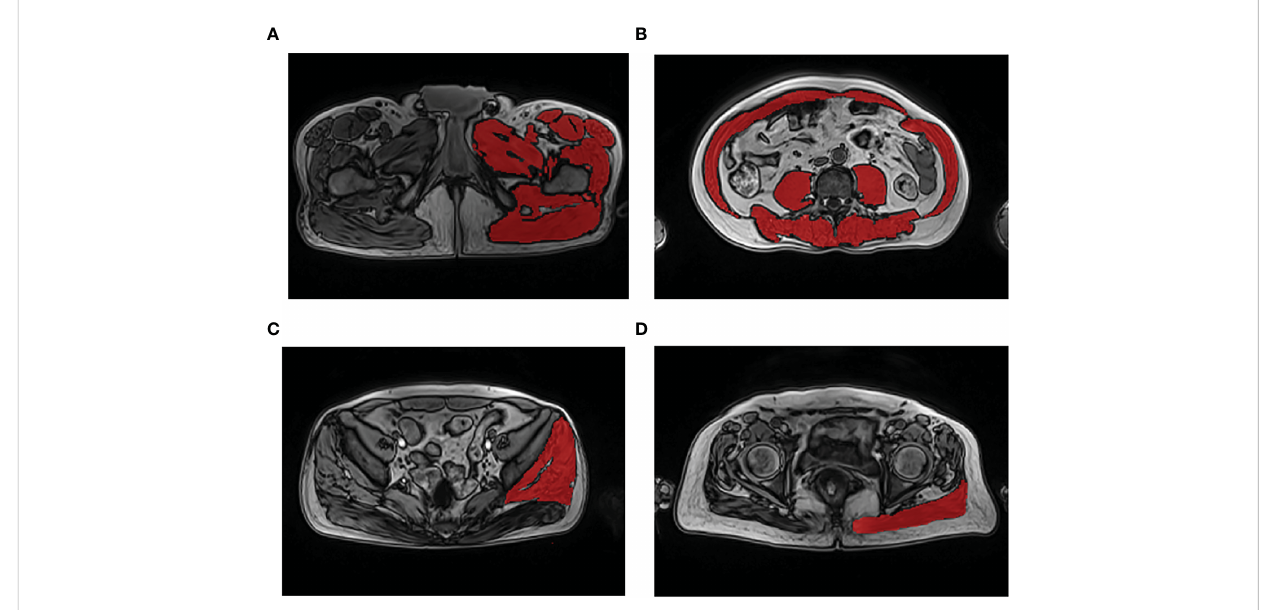
FIGURE 1 Demonstration of muscle segmentation. Measurement of the left thigh muscle group at the level 3 cm below the lesser trochanter (A) ; measurement of the trunk muscle at the level of the third lumbar vertebra transverse process (B) ; measurement of the left gluteus medius and minimus muscles at the third sacral (S3) level (C) ; measurement of the left gluteus maximus muscle at the level of the greater trochanter of the femur gluteus (D)